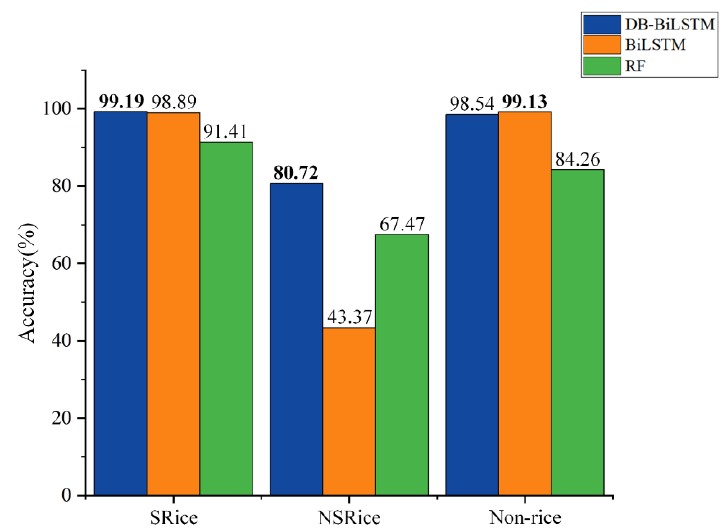
Figure 8. Accuracy of SRice, NSRice, non-rice based on different methods. (Bold in the figure indicates the accuracy obtained by the best model in different classes).